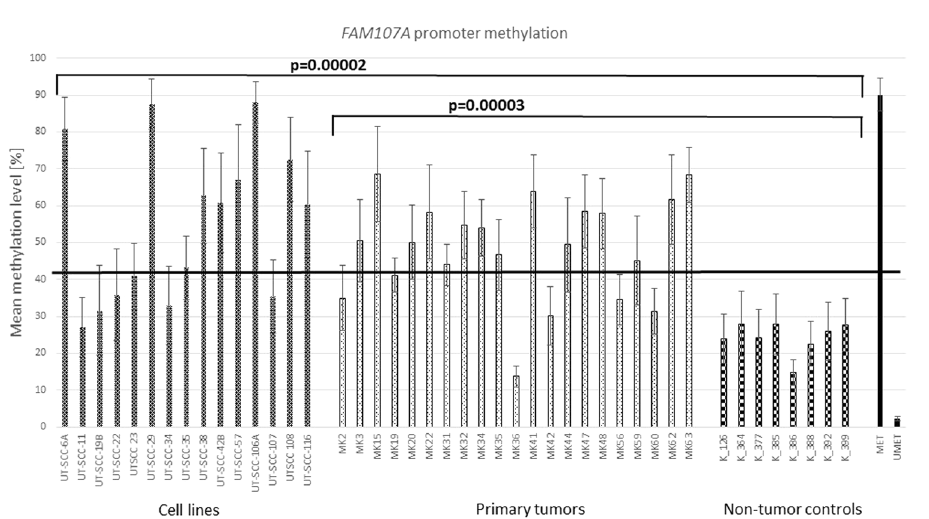
Figure 3. Mean methylation of FAM107A promoter region in analyzed cell lines, primary tumors and non- cancer controls. The flat black line indicates the cut off value of 41%, above which samples are assigned as